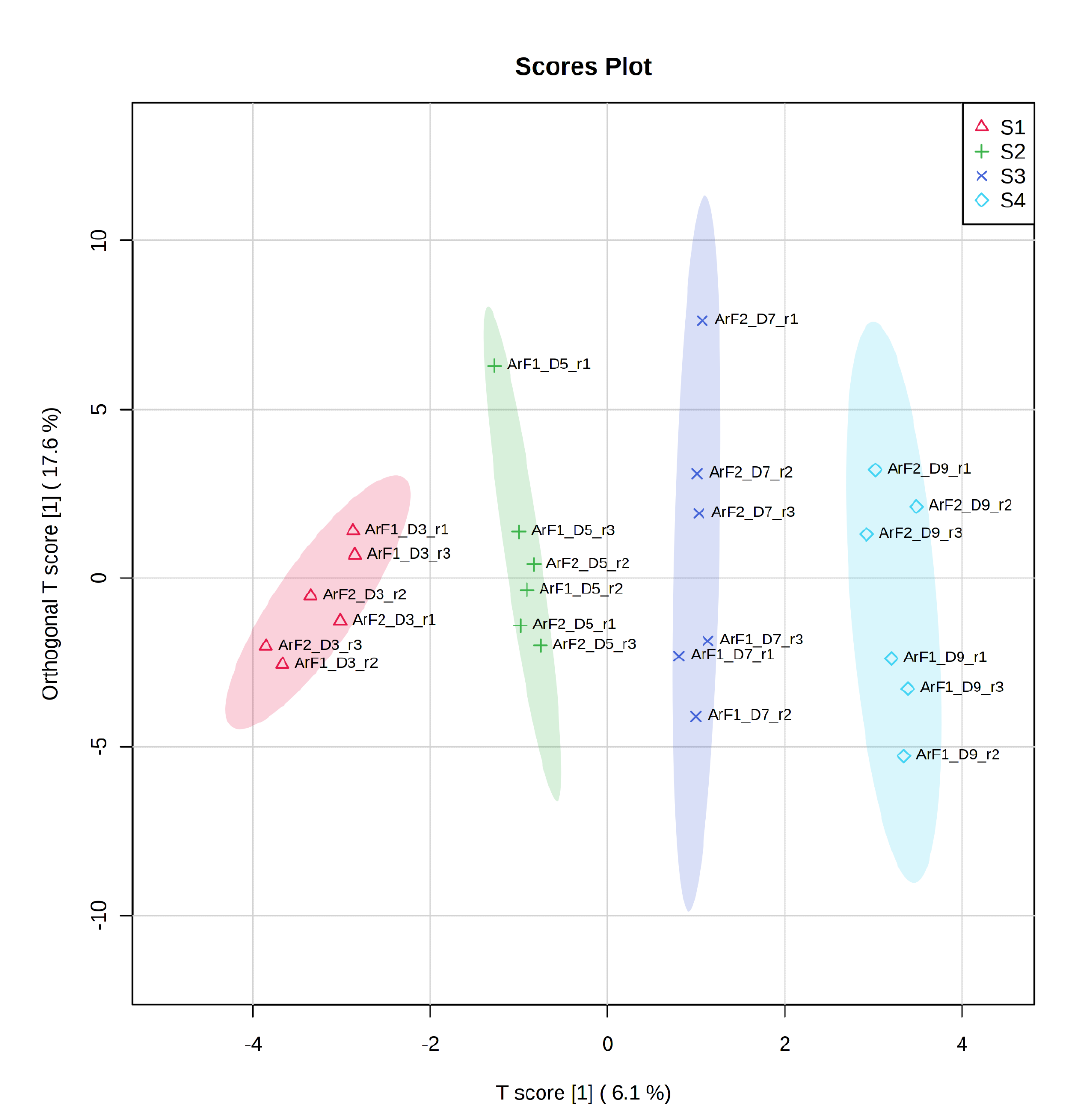
Figure 4. OPLS-DA modeling of volatile compounds’ variations during storage of whole (ArW) and filleted (ArF) meagre caught in January (1) and July (2). Models with one predictive and three orthogonal components were built with the volatile compounds as predictors and the sampling points (S1, S2, S3, S4) as the response. ( A ) Score plot of whole meagre during storage at 0 °C for 3, 6, 12 and 15 days, ( B ) Score plot of filleted meagre during storage at 4 °C for 3, 5, 7 and 9 days. The sampling points S1, S2, S3 and S4 correspond to the increasing days of fish storage. The percentage of the explained response variance is indicated in parentheses. The shaded ellipses correspond to the 95% confidence regions of each class.